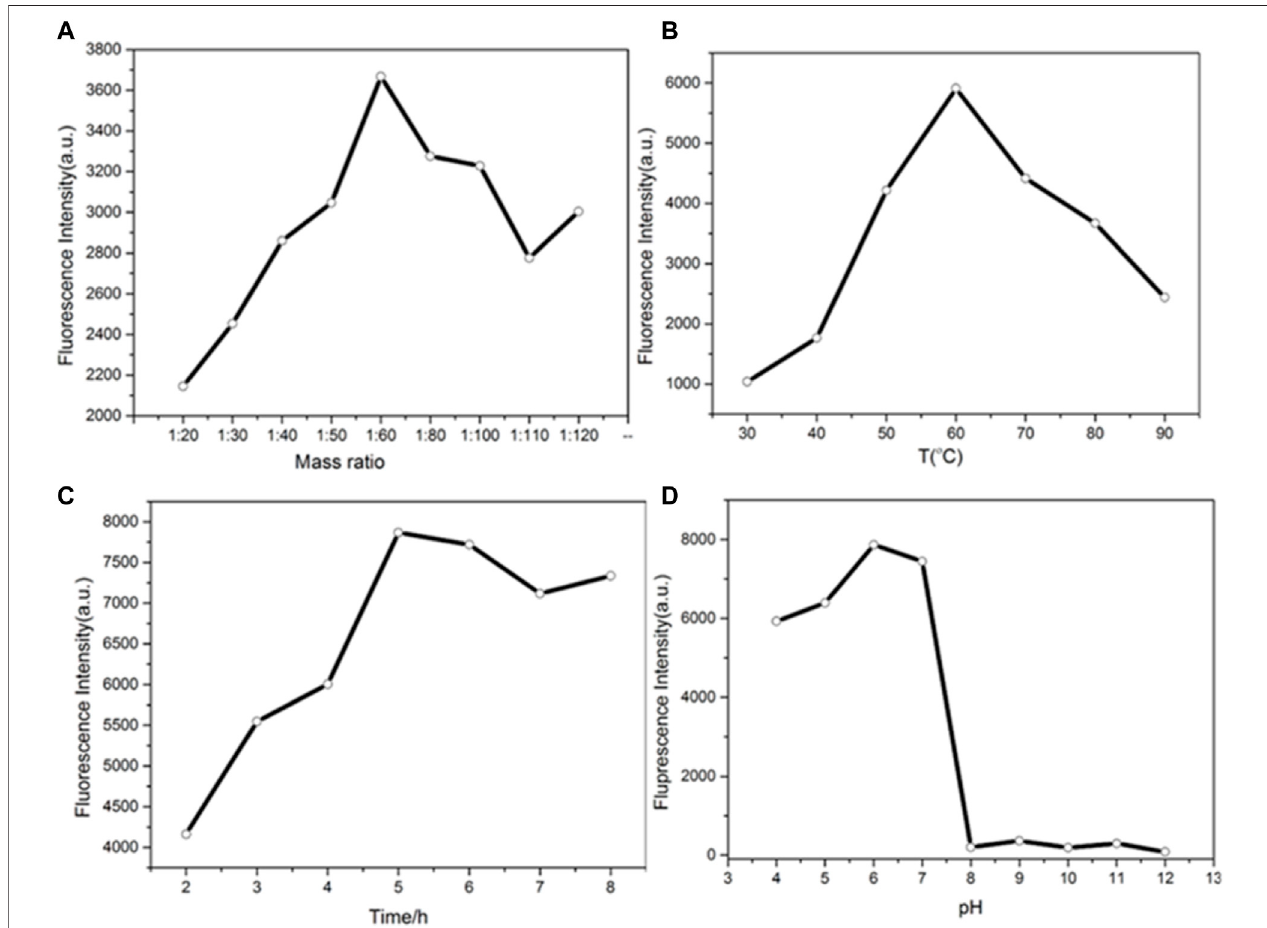
FIGURE 3 | (A) Determinationofthemassratioofthesynthesized CuNPs; (B) temperatureofthesynthesizedCuNPs; (C) timeofCuNPsynthesis; (D) pHofCuNPsynthesis.